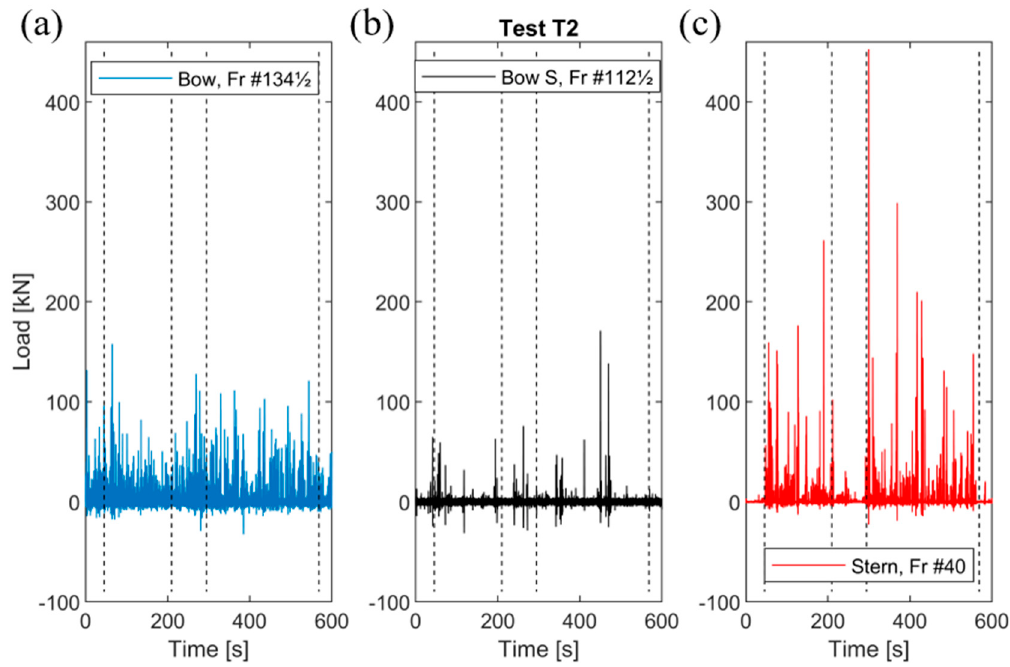
Figure A11. Measured ice-induced loads at ( a ) bow, ( b ) bow shoulder, and ( c ) stern shoulder during tests T2_1 and T2_2.